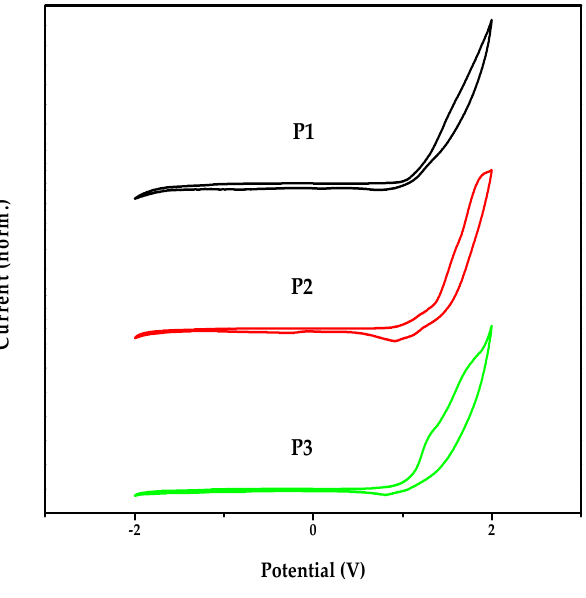
Figure 3. Cyclic voltammogram of P1, P2 and P3.